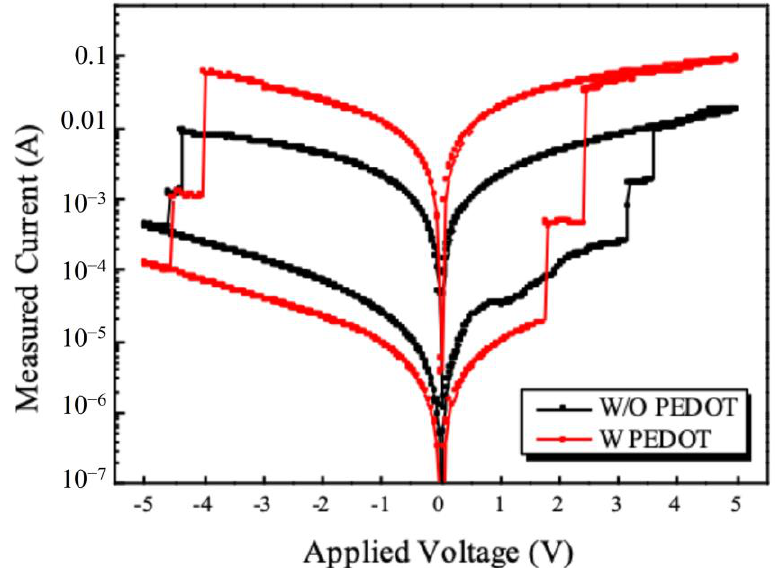
Figure 7. Current–voltage (I-V) characteristics of fabricated memory device.